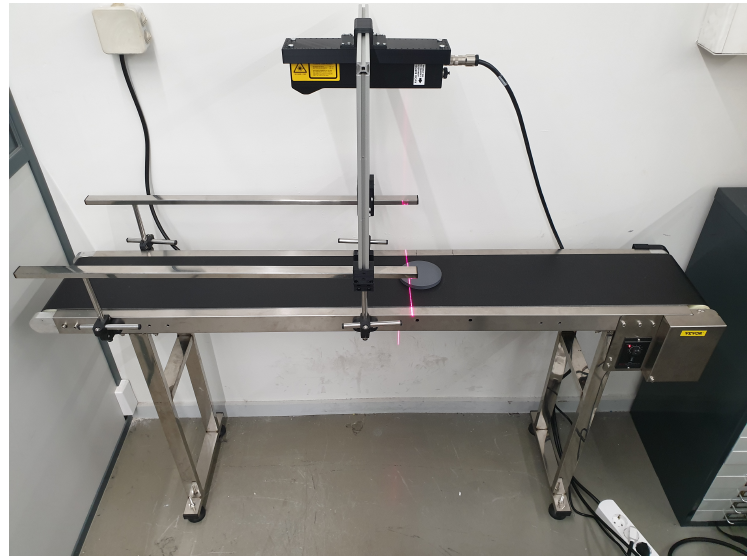
Figure 3. Assembled setup.